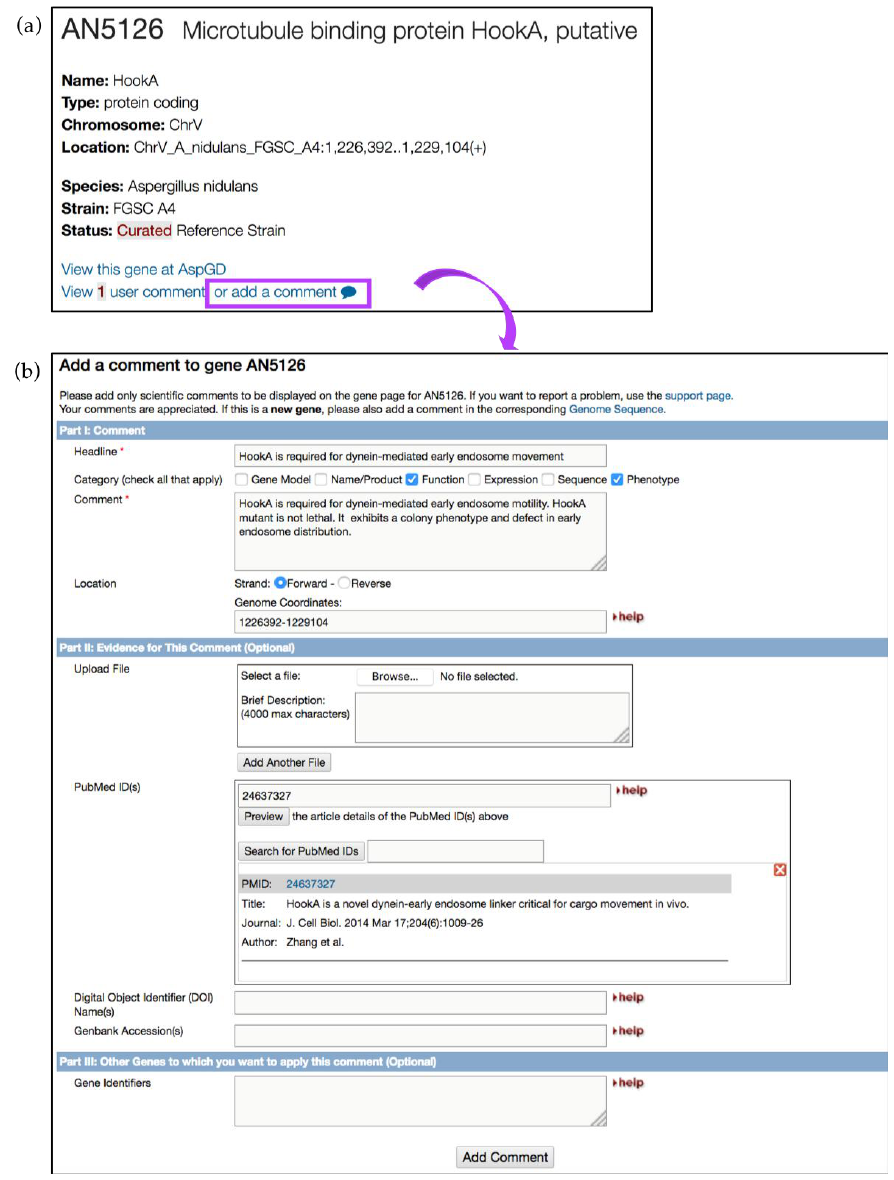
Figure 21. Improving gene records via user comments. ( a ) Shown is a gene record page for a putative microtubule-binding protein HookA AN5126 gene in A. nidulans . To add a comment, click on the